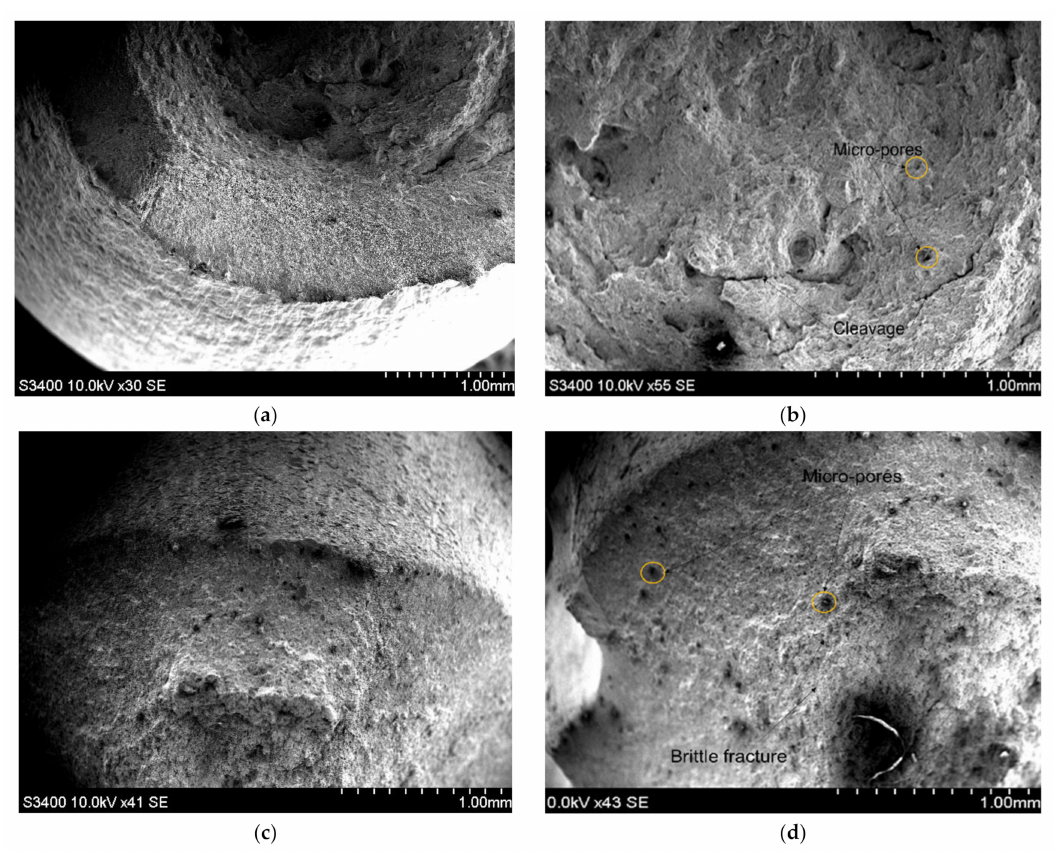
Figure 9. SEM images obtained after the tensile test in the fractured zone of: ( a ) aluminum sample ( b ) aluminum sample; ( c ) stainless steel sample; ( d ) stainless steel